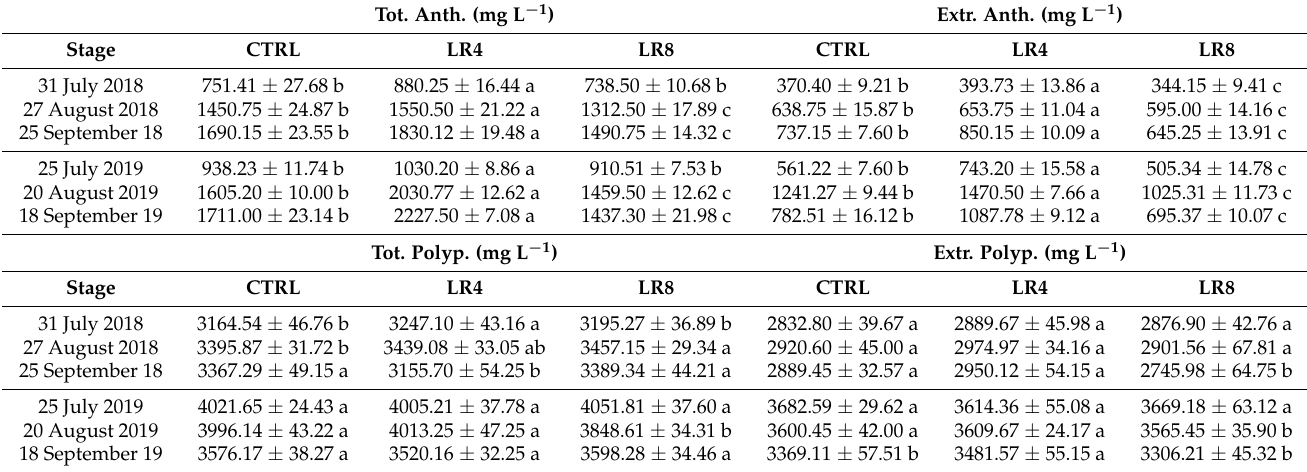
Table 4. Phenolic maturity. Total anthocyanin (Tot. Anth.), extractable anthocyanin (Extr. Anth.), total polyphenol (Tot. Polyp.), and extractable polyphenol (Extr. Polyp.) contents of V. vinifera treated with three different defoliation managements: four leaf removal (LR4), eight leaf removal (LR8), and no defoliation (CTRL). Measurements were conducted at full veraison (31 July 2018 and 25 July 2019), mid-maturation (27 August 2018 and 20 August 2019) and full maturation (25 September 2018 and 18 September 2019). Data (mean ± SE, n = 10) were subjected to one-way ANOVA. Different letters within the same parameter and row indicate significant differences (LSD test, p ≤